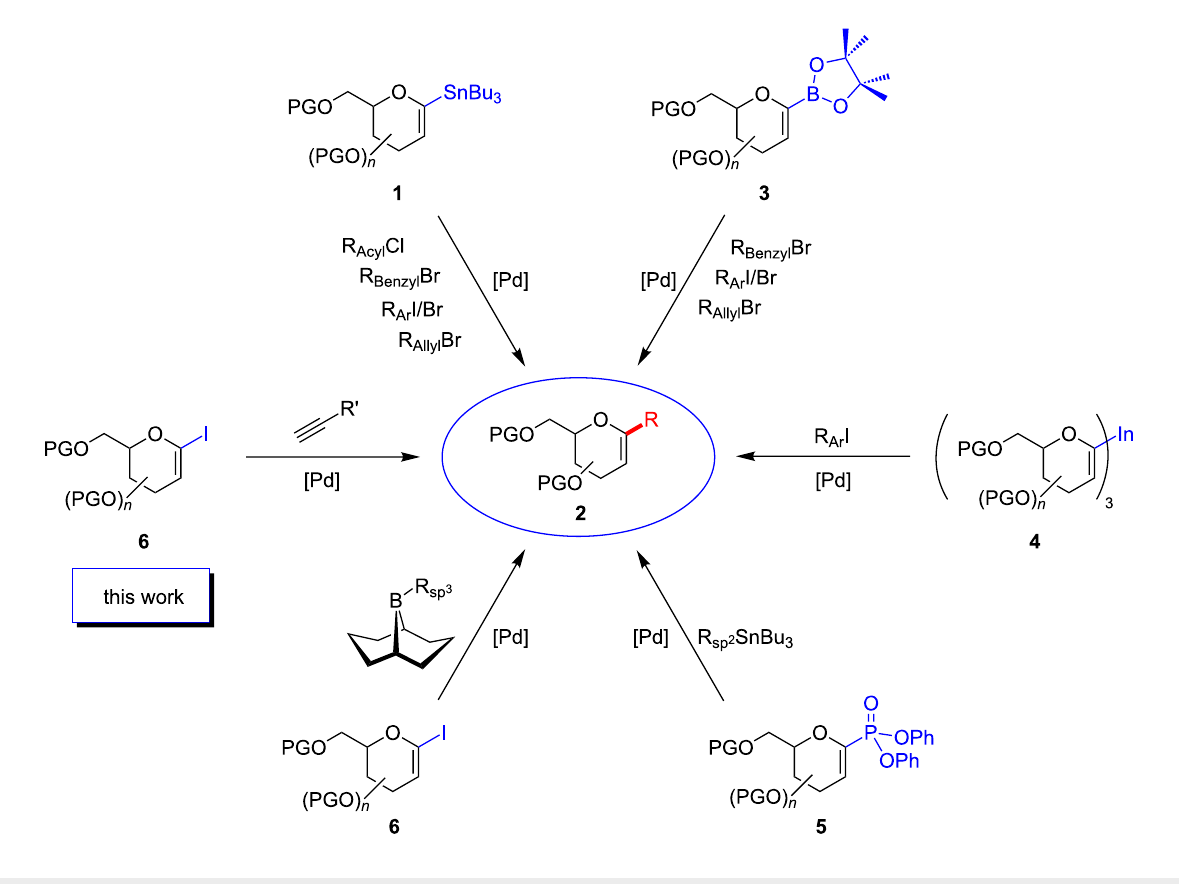
1-substituted glycals a prefunctionalization of the